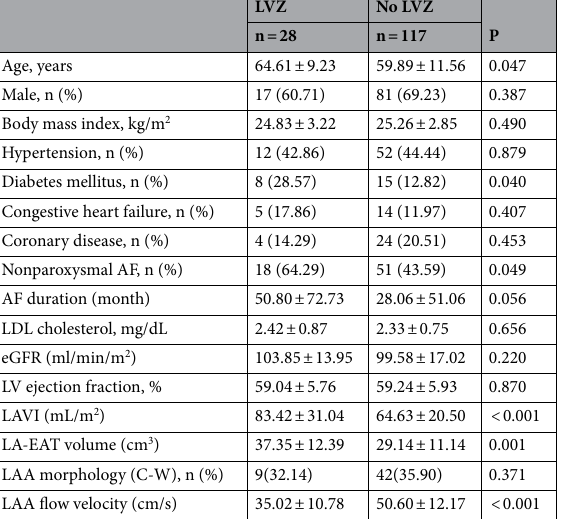
Table 2. Comparison of baseline data and echocardiographic parameters. LVZ, Low Voltage Zone; AF, atrial fibrillation; LDL-C, Low-density lipoprotein; LV, left ventricular; LAVI, left atrial volume index; LA, left atrial; EAT, Epicardial adipose tissue; LAA, Left atrial appendage; C-W, chicken-wing type.